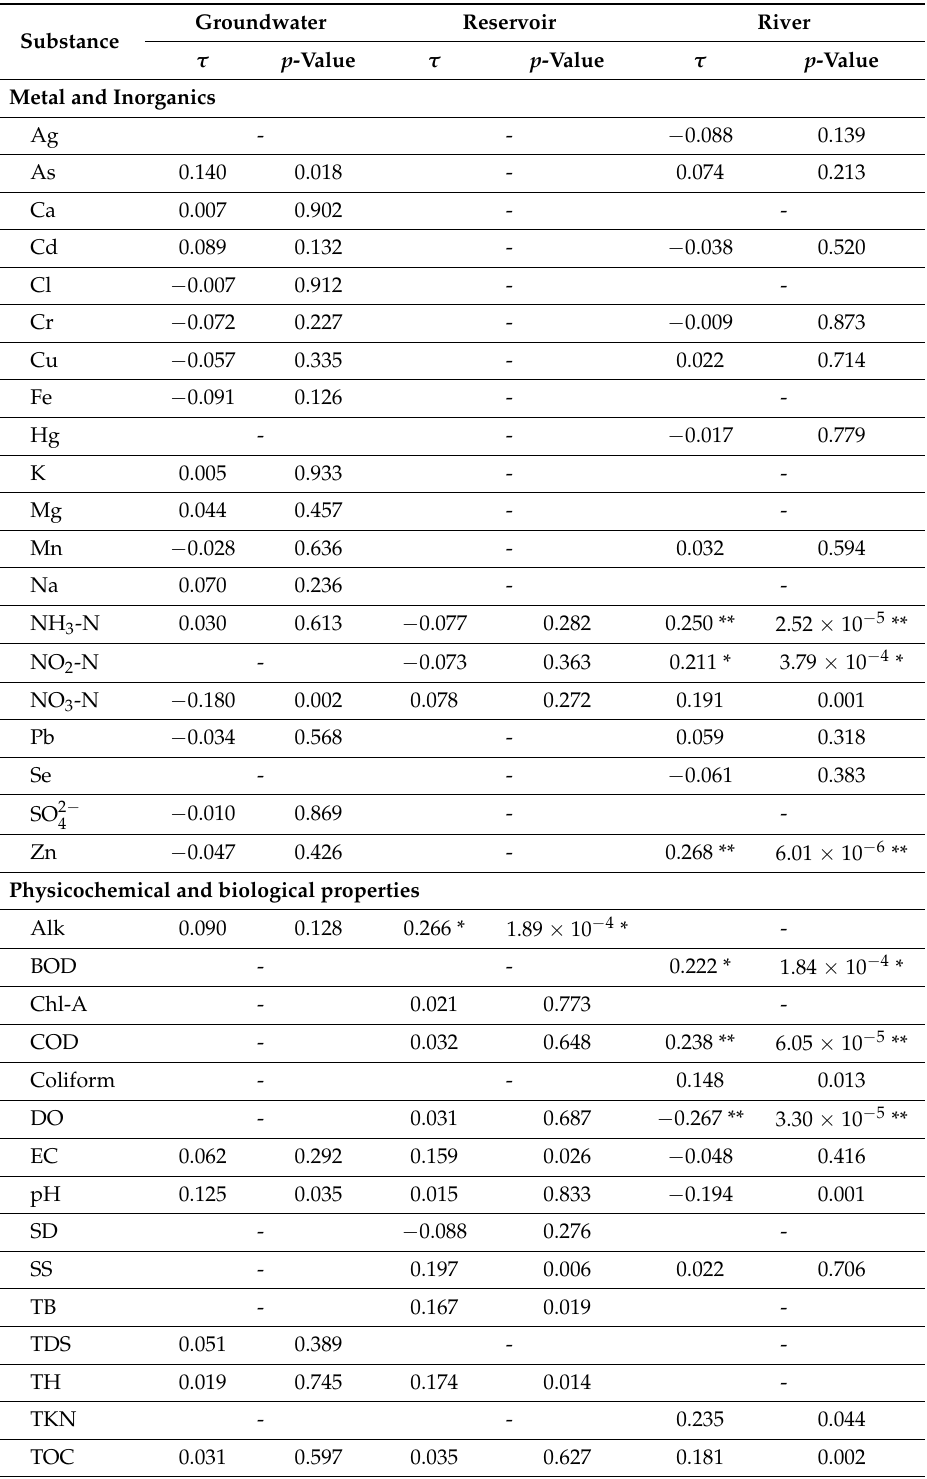
Table 2. The correlation between water attribute and age-standardized CKD prevalence rate, adjusting for gender, age, and annual effects